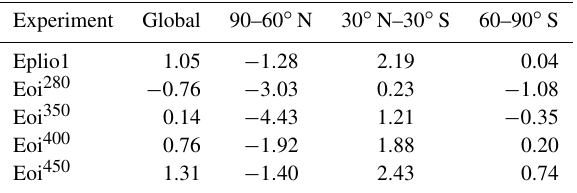
Figure 13. (a) The total meridional heat transport in the Pliocene experiments and in E 280 , as calculated from the top-of-atmosphere radiative transport, and (b) the anomaly between the Pliocene ex- periments and E 280 . The core experiment, Eoi 400 , is shown in bold green. Table 4. The difference between the annual mean SST anomaly (from E 280 ) of each experiment and the equivalent from the PRISM3 proxy data. Positive values signify that the increase in model SST is greater than the increase in proxy SST. Units are de- grees Celsius. The PRISM3 proxy data were used as SST boundary conditions for AGCM experiments in